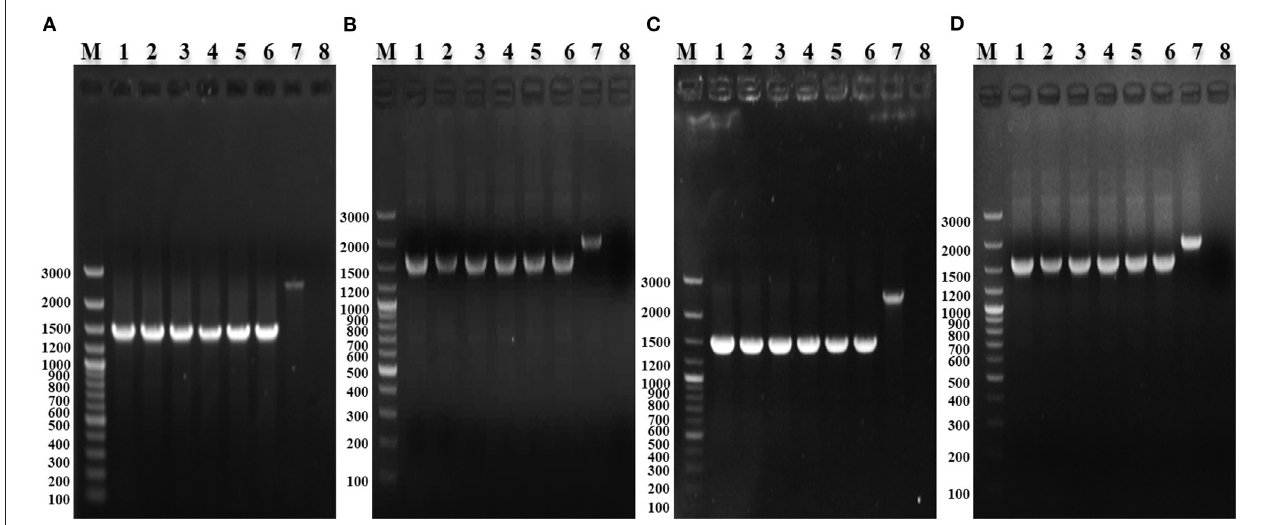
FIGURE 2 | PCR identification of the stability of S. enterica ser. Gallinarum deletion strains. (A) PCR identification of SG005 1 waaJ with W6/W7. M: GeneRuler 100 bp Plus DNA Ladder (Thermo Fisher Scientific, Waltham, MA, USA); 1–6: PCR-amplified products from the 10th, 20th, 30th, 40th, 50th, and 60th passages of SG005 1 waaJ ; 7: Wild-type SG005; and 8: Negative control. (B) PCR identification of SG005 1 spiC with S6/S7. M: GeneRuler 100 bp Plus DNA Ladder; 1–6: PCR-amplified products from the 10th, 20th, 30th, 40th, 50th, and 60th passages of SG005 1 spiC ; 7: Wild-type SG005; and 8: Negative control. (C) PCR identification of SG005 1 waaJ 1 spiC with W6/W7. M: GeneRuler 100 bp Plus DNA Ladder; 1–6: PCR-amplified products from the 10th, 20th, 30th, 40th, 50th, and 60th passages of SG005 1 waaJ 1 spiC ; 7: Wild-type SG005; and 8: Negative control. (D) PCR identification of SG005 1 waaJ 1 spiC with S6/S7. M: GeneRuler 100